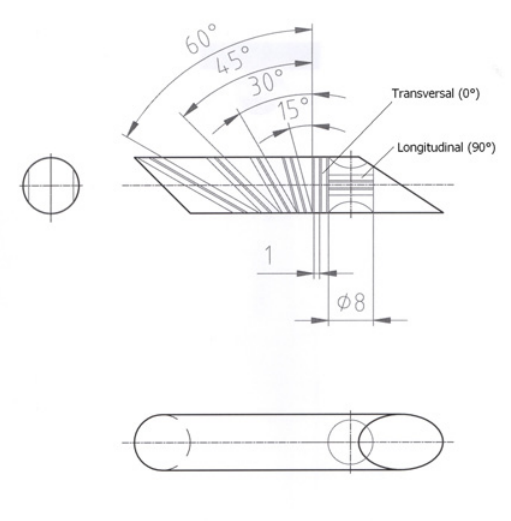
Figure 3. The schematic illustration of the cutting of the specimens.